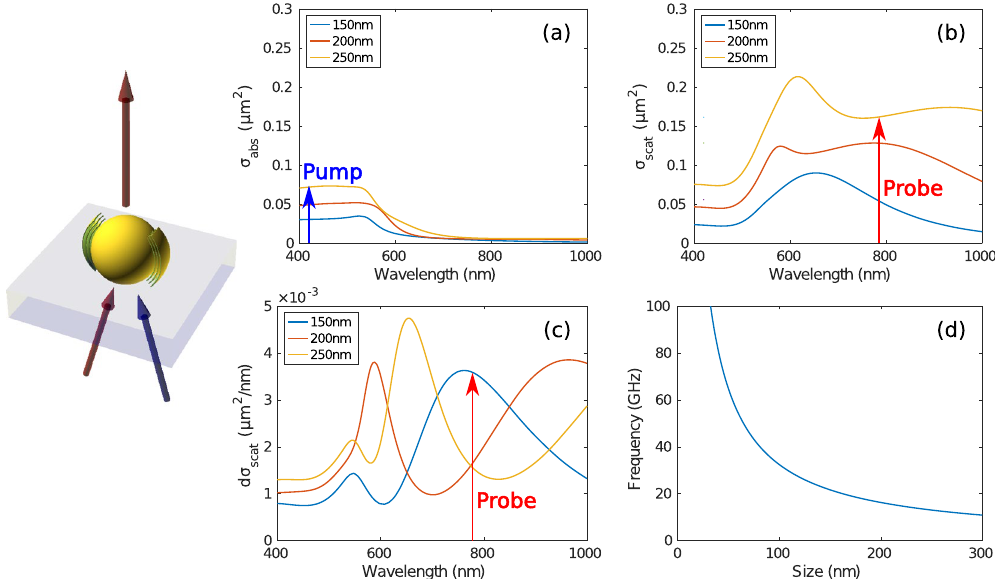
Figure 2. Modelled response of nano-bells. (left) Schematic of the experiment from the nanoparticles’ point of view. The particle sits on the transparent substrate and is illuminated by the pump beam and probe beam from below. The scattered light is collect in transmission from above. ( a ) The optical absorption cross section for the gold nanoparticles used in the experiment calculated using Mie theory for the pump wavelength. ( b ) The optical scattering cross section calculated for the probe wavelength, ( c ) the derivative of ( b ) with respect to size, and ( d ) the vibration frequencies of the particles as a function of size.